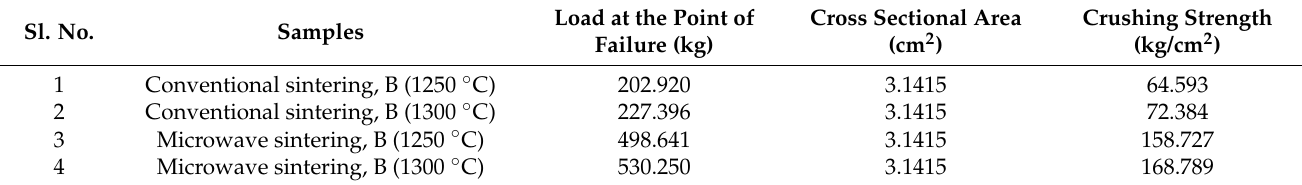
Table 4. Results of cold crushing strength test.